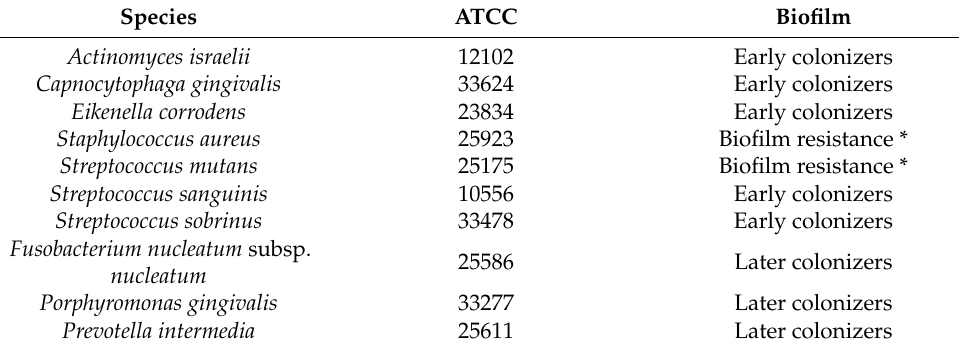
Table 1. Oral species